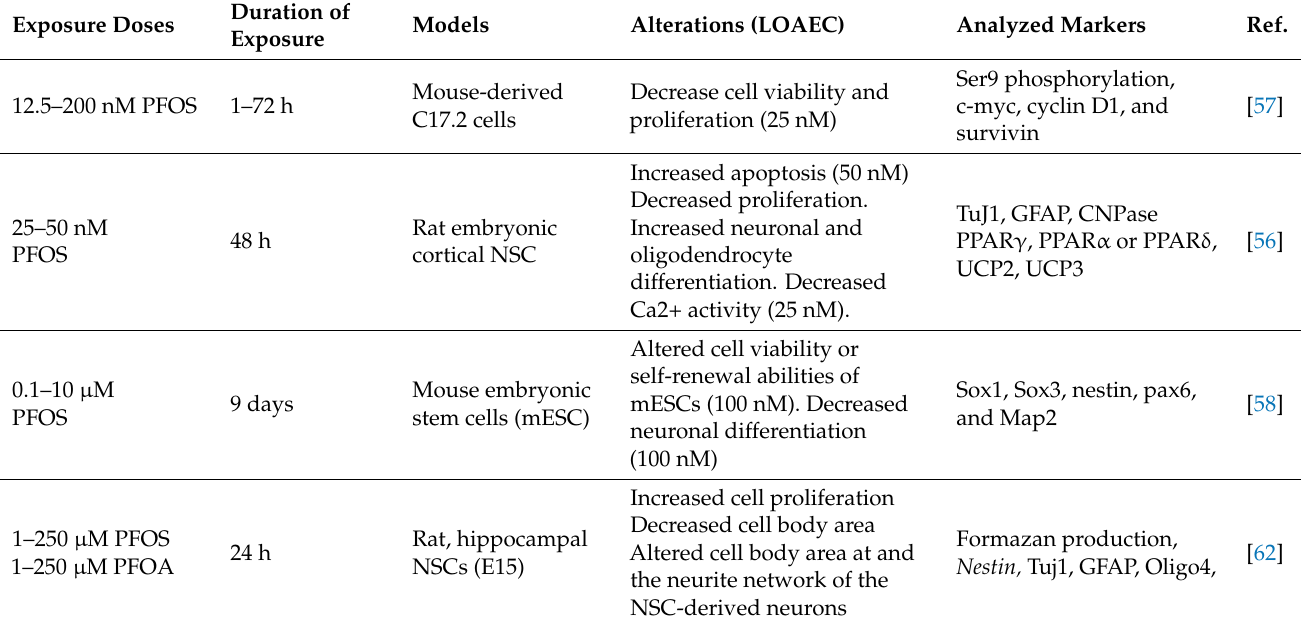
Table 2. Studies reporting on the effects of PFOS or PFOA in